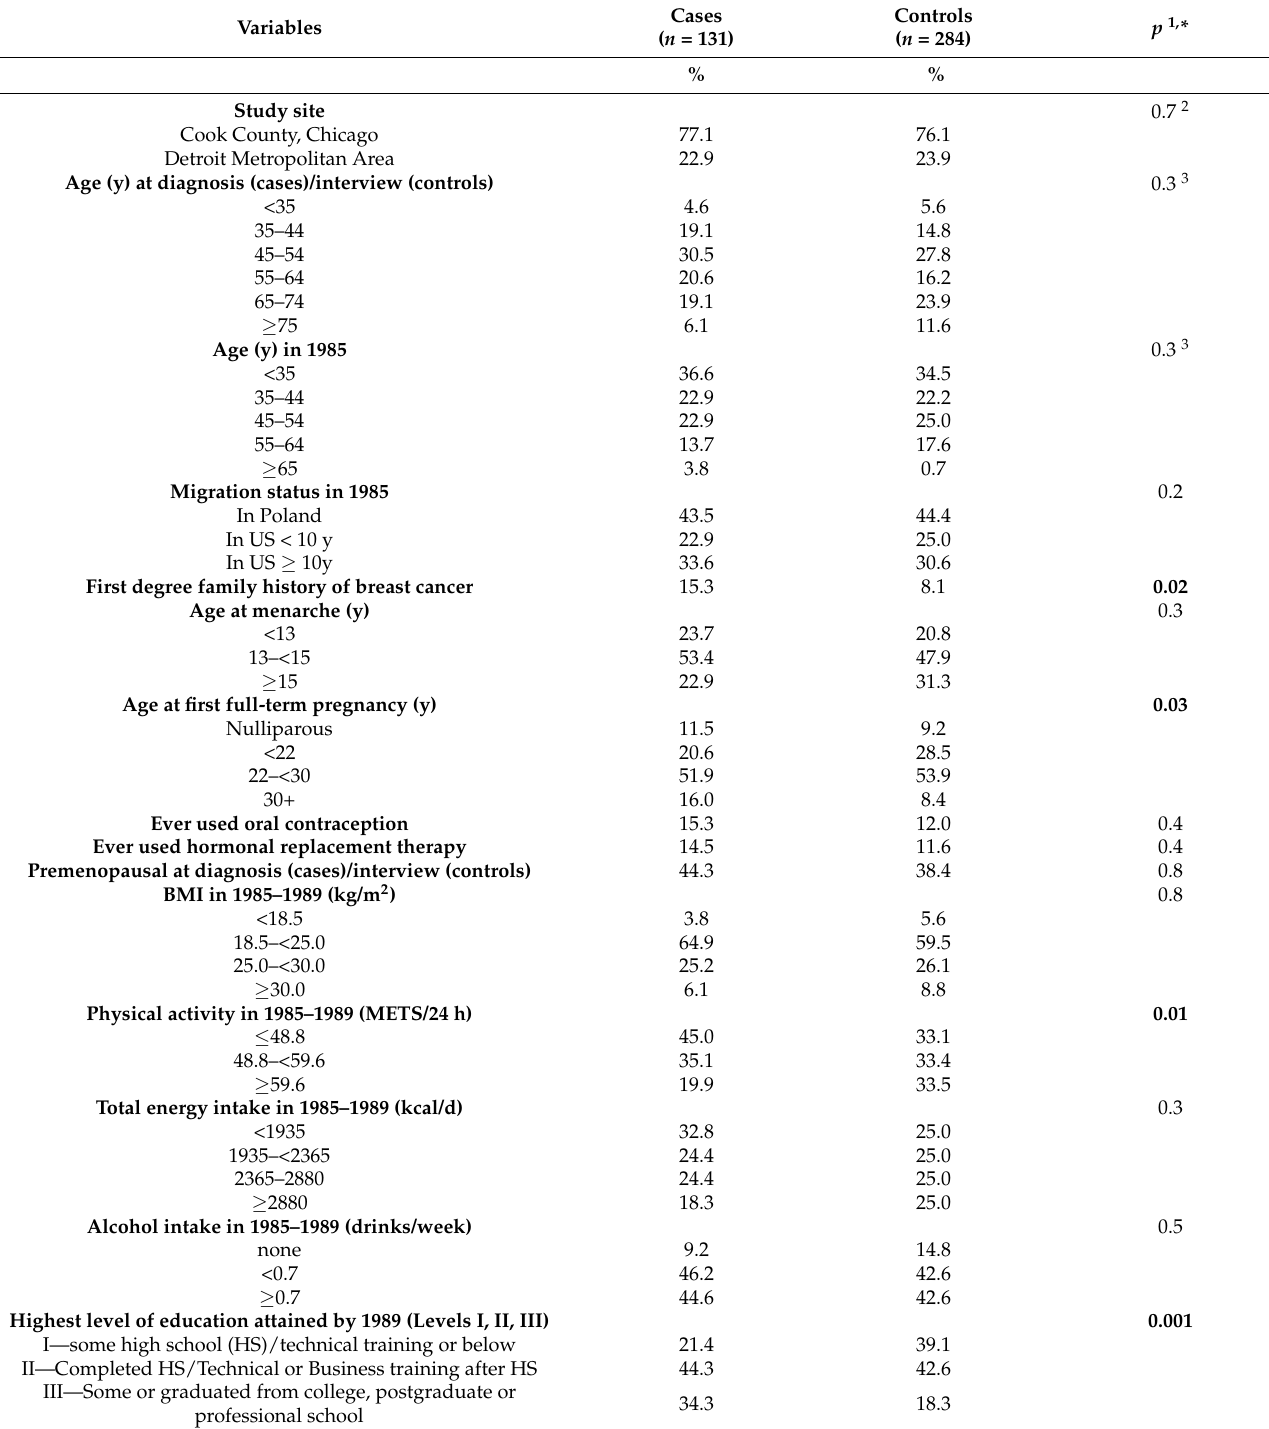
1 Comparison between cases and controls, within the combined strata of age at diagnosis(cases) or interview (controls) (<35 y; 35–44 y; 45–54 y; 55–64 y; 65–74 y; ≥ 75 y) and site (CC, DMA); For DMA (ages <35 y and 35–44 y) combined due to small sample size. 2 Adjusted for age at diagnosis (cases) or interview (controls). 3 Adjusted for site. * Bold indicates statistical significance of p <